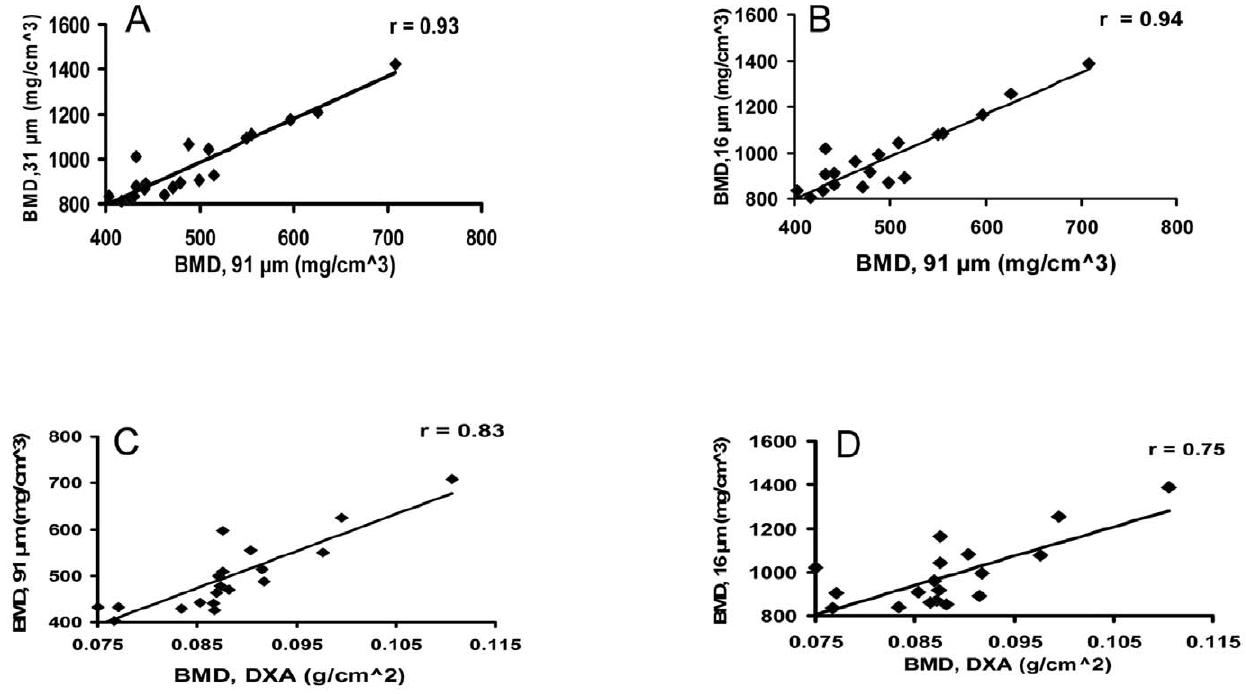
Figure 4. In vivo m CT and ex vivo specimen m CT measurements of bone mineral density (BMD) correlate with each other and with ex vivo dual-energy X-ray absorptiometry (DXA) BMD measurements. (A) In vivo m CT at 91- m m vs ex vivo m CT at 31- m m voxel size. (B) In vivo m CT at 91- m m vs ex vivo m CT at 16- m m voxel size. (C) In vivo m CT at 91- m m vs ex vivo DXA. (D) Ex vivo m CT at 16- m m vs ex vivo DXA.